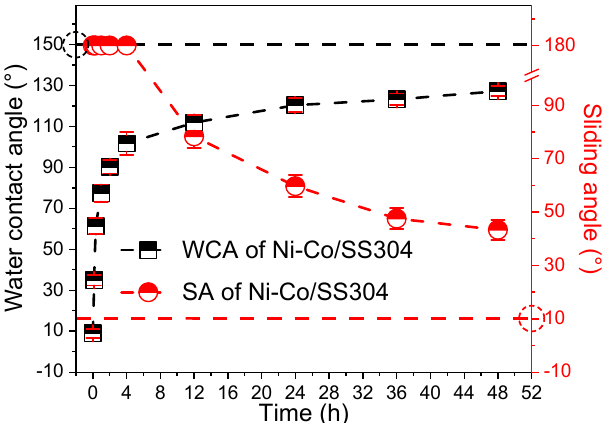
Figure 4. WCA and SA changes in Ni–Co/SS304 surface with annealing time.